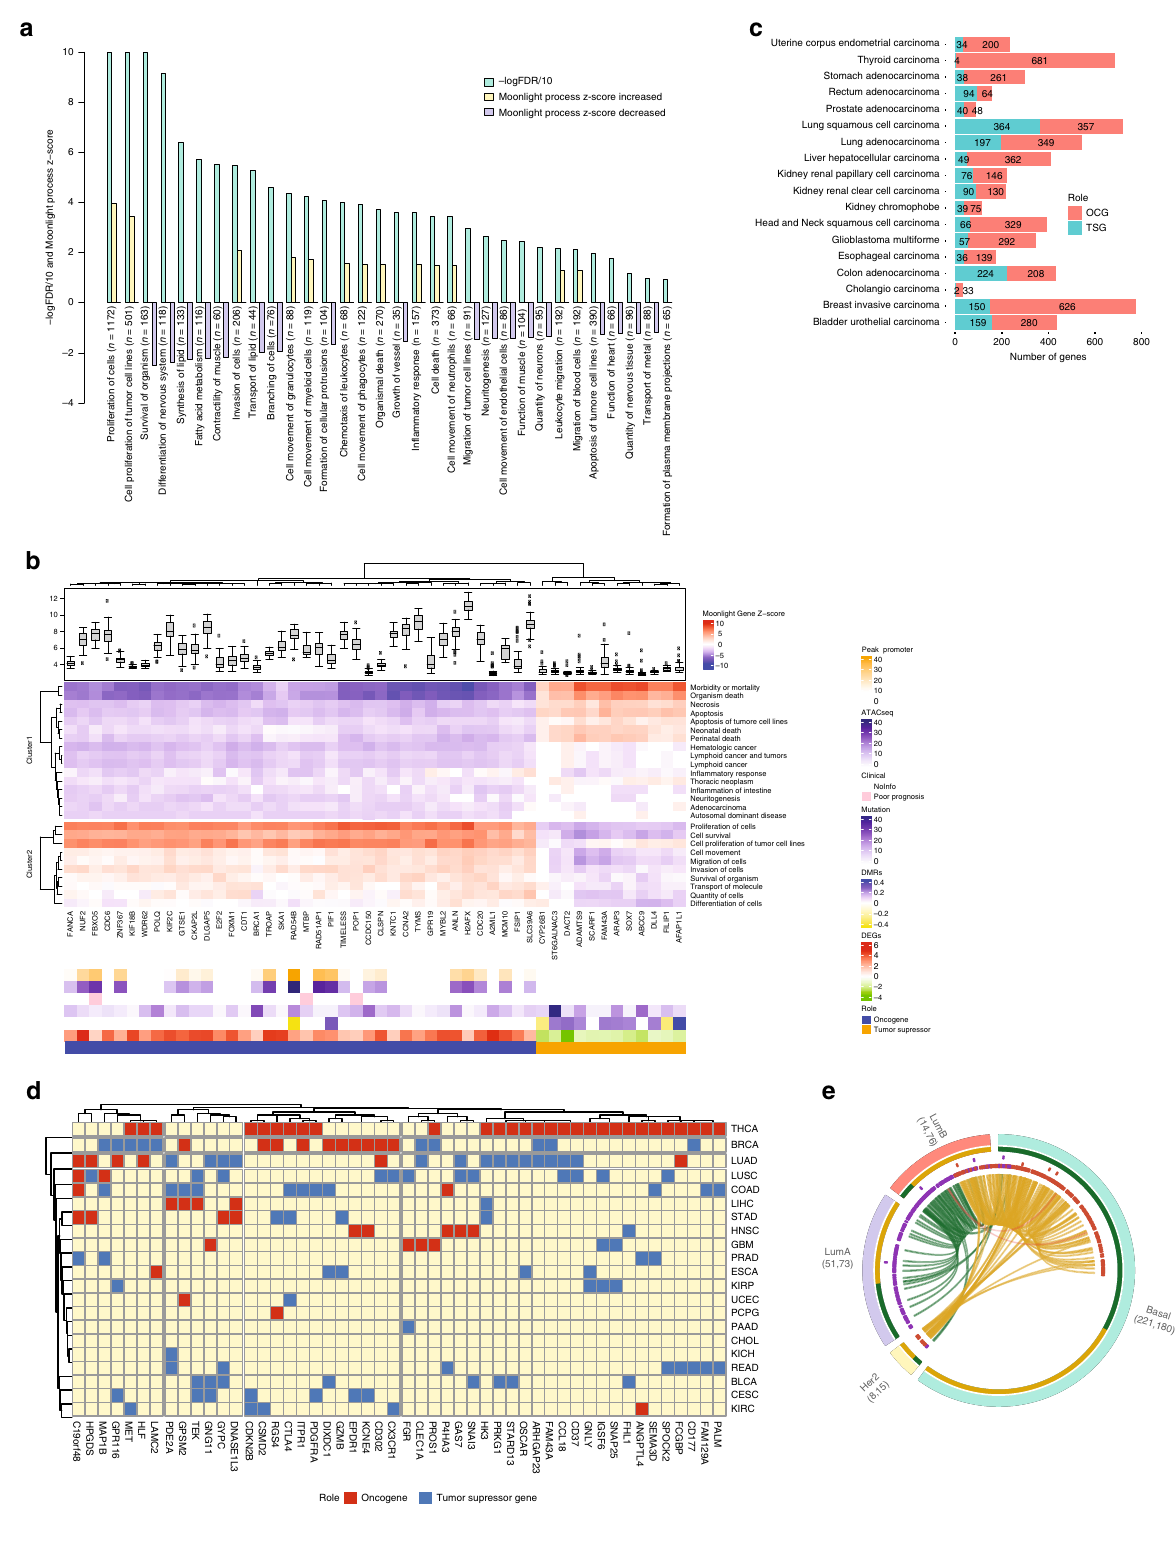
patterns using DNA methylation. In the literature, we observe the existence of two broad classes of CpG-methylated sites: (i) those with a strong inverse correlation between DNA methylation and chromatin accessibility across cell types and (ii) those with vari- able chromatin accessibility but constitutive hypomethylation 27 . Therefore, we identi fi ed differentially methylated regions between normal and tumor samples for 18 TCGA cancer types (Methods).